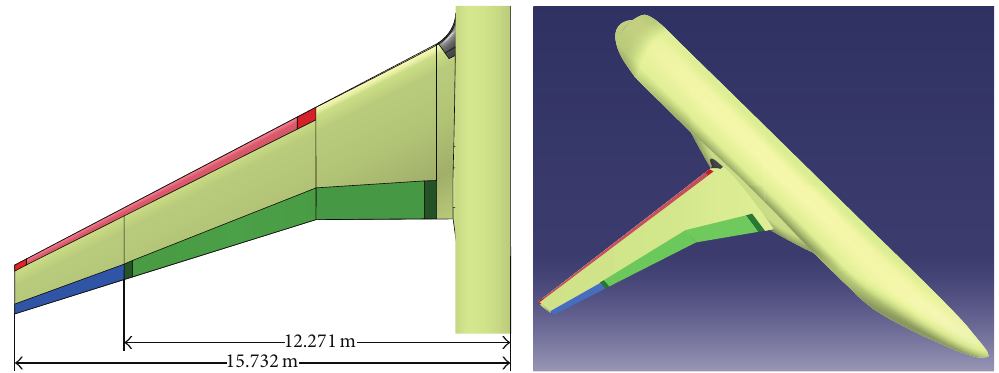
Figure 10: Reference Aircraft with morphing wing configuration and corresponding wing planform.